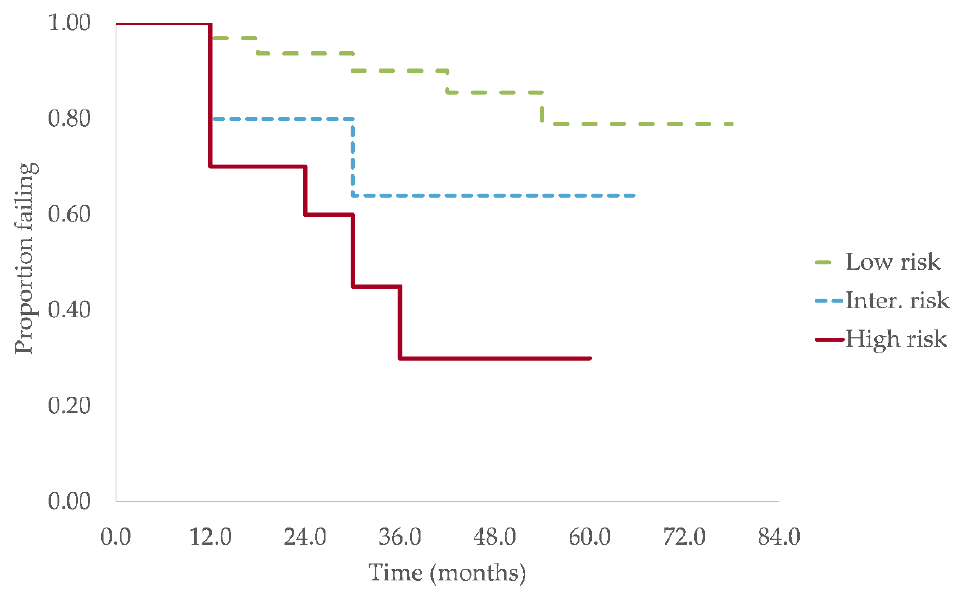
Figure 1. Progression free survival for the three risk groups according to the new Mayo Clinic model. Kaplan–Meier failure curves showing PFS for the low-risk group, intermediate-risk group and high-risk group. The estimated median TTP was not reached for the low and intermediate risk groups and was 29.1 months (95% C.I., 3.9–54.4) in the high-risk group ( p = 0.006). The overall 1, 2 and 5 years PFS rate were, respectively, 87.6%, 81.6% and 60.8%. When subdivided into risk groups, the estimated proportion of progression-free patients at 1, 2 and 5 years were 96.8%, 93.4% and 77.5% for the low-risk group, 80.0%, 80.0% and 62.2% for the intermediate risk group and 70.0%, 58.3% and 29.2% for the high-risk group. Overall, 25.8% (23/89) of our cohort died during follow-up. Only 39.1% (9/23) of those deaths were related to their gammopathy. The median age at death for the entire cohort was 80.0 years (range 62.5–89.4 years). In the subset of patient who died of a symptomatic